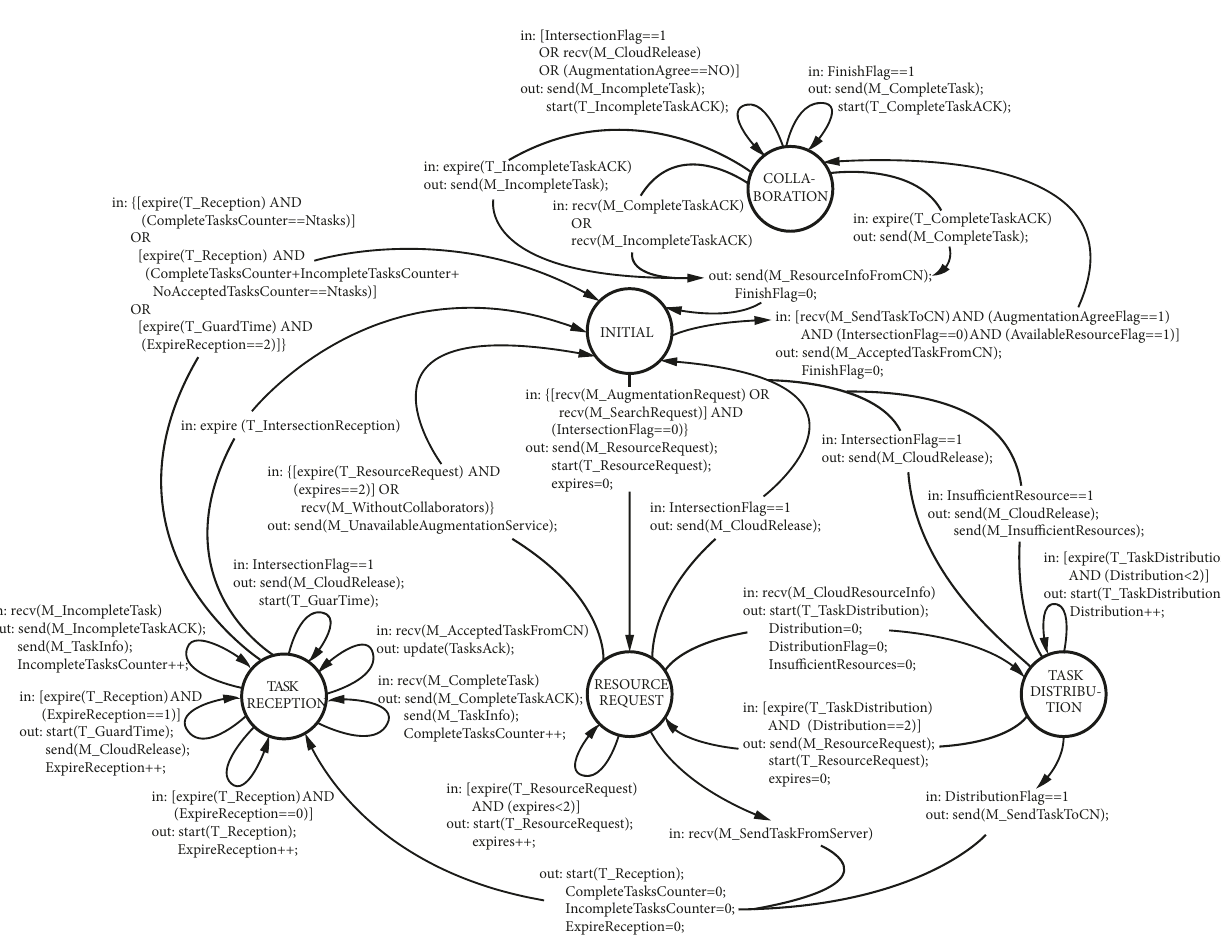
Figure 10: State machine of our S-CMA approach that supports the proposed NaaS model. This figure is reproduced from